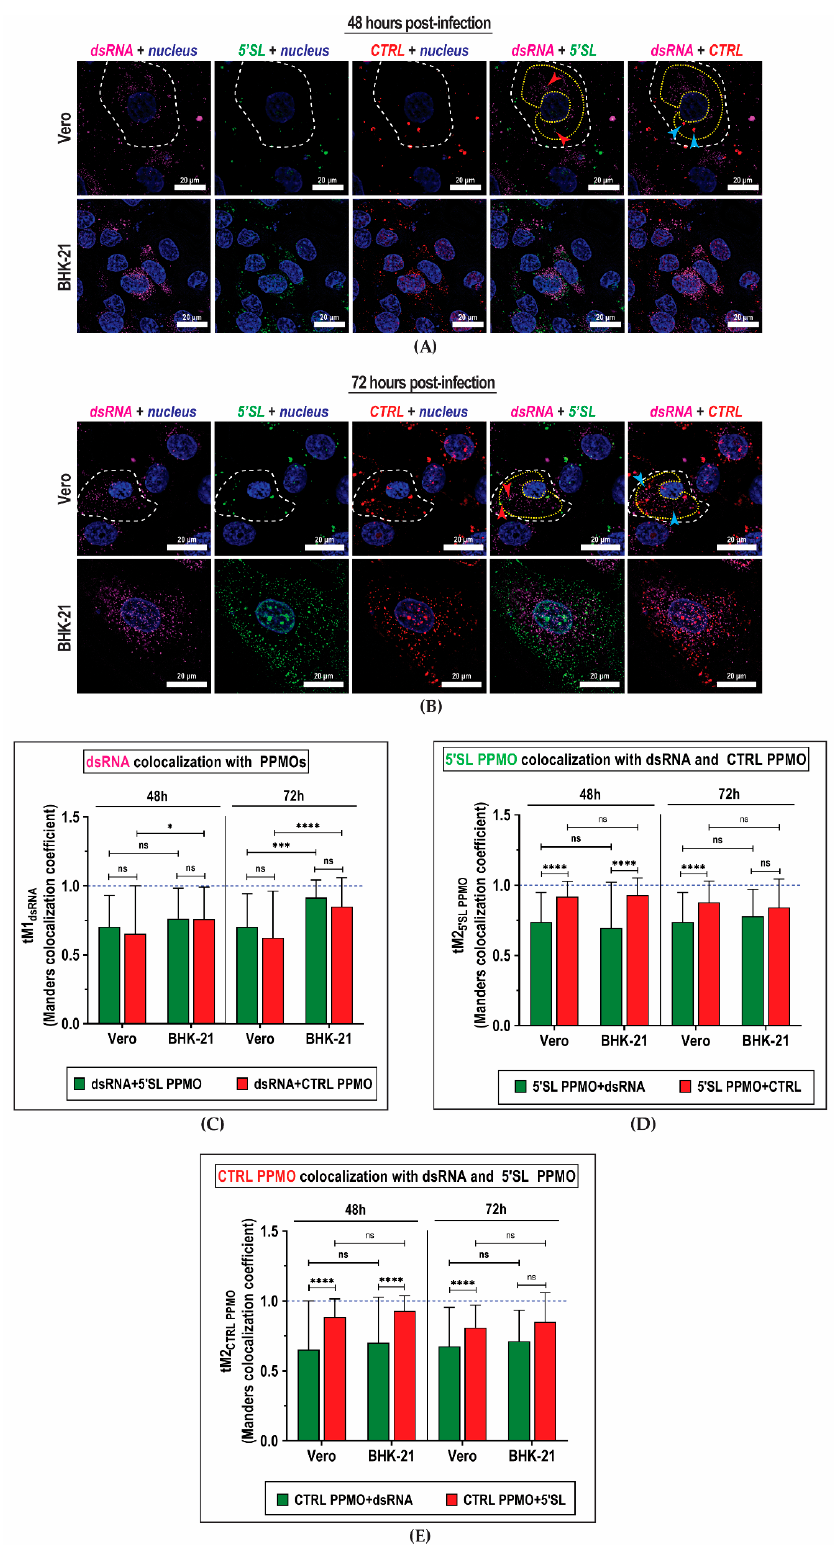
Figure 2. Colocalization of PPMOs with Dengue virus replication complex in vesicle packets. ( A , B ) Representative deconvoluted fluorescence images of monkey kidney (Vero) and baby hamster kidney (BHK-21) cells infected with 1 MOI Dengue virus serotype-2 (DENV2). Cells incubated with both targeted 5 (cid:48) SL and non-targeted CTRL PPMOs (10 µ M final concentration each) at 1 h